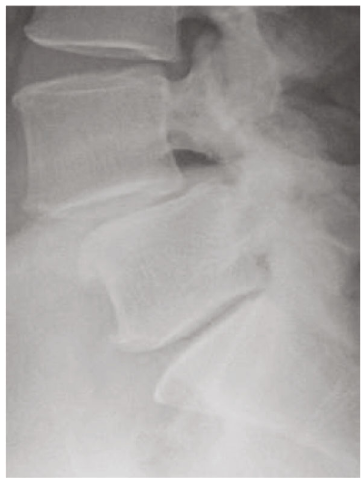
Figure 1: Preoperative lateral lumbar X-ray.